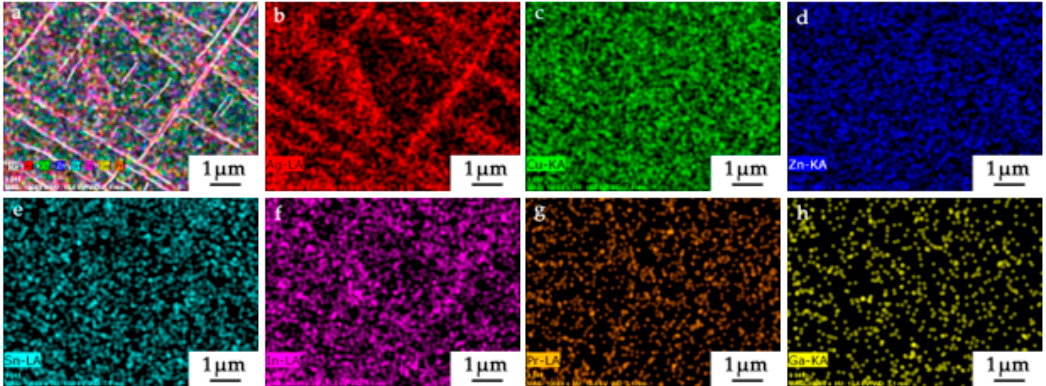
Figure 8. ( a ) The elements mapping of SEM image of 12AgCuZnSn-2In-0.15Pr-2Ga filler metal marked with white square in Figure 7 ( e ), ( b – h ) EDX element mappings of the distribution of Ag, Cu, Zn, Sn, In, Pr, and Ga, respectively.